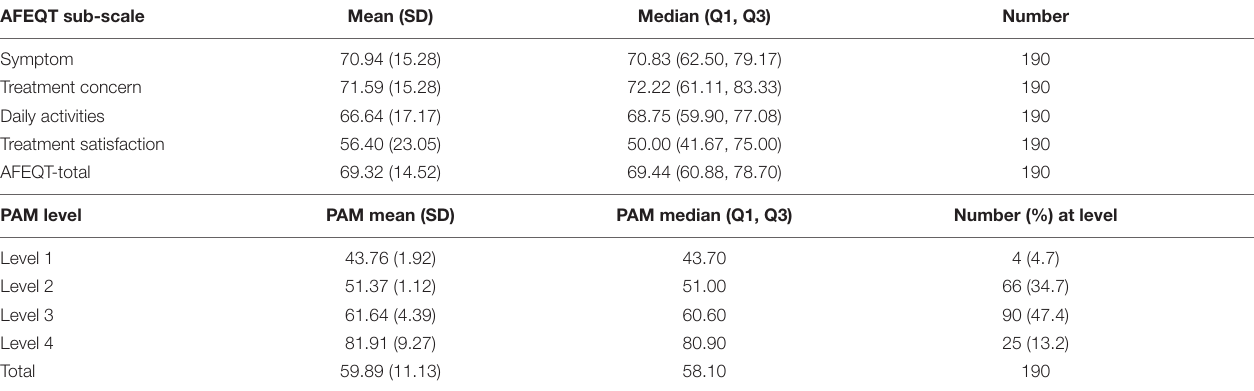
TABLE 2 | Description of AFEQT total and subdimensions score and PA levels for the sample. AFEQT